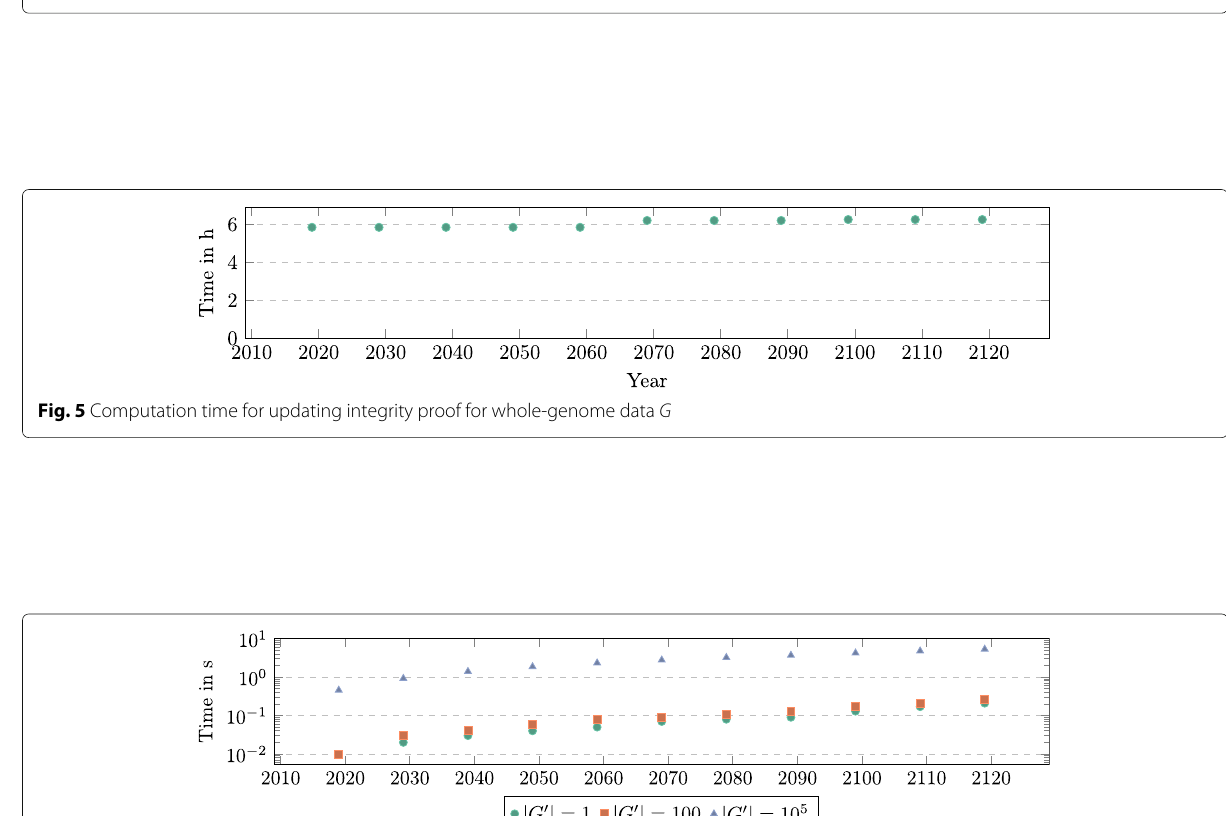
Fig. 4 Projected yearly storage costs of integrity proofs. The calculation starts with initially $15 per TB, then reduces the costs per TB by a rate of R = 1, 2 and 4 per 10 years. HDDs are assumed to be replaced every 5 years